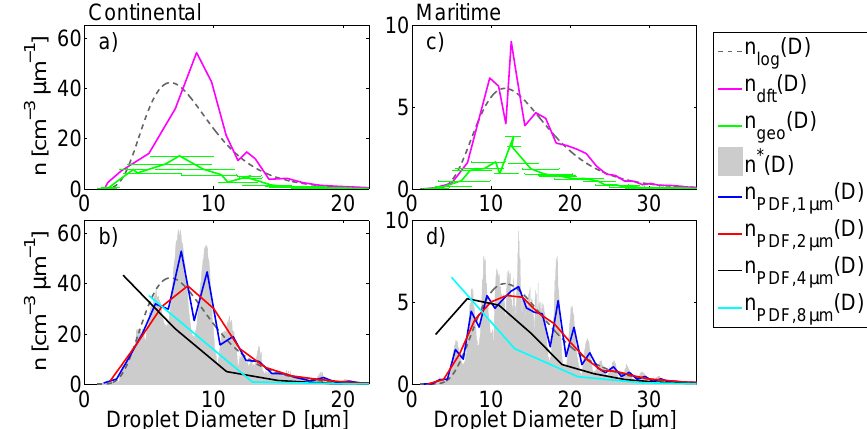
Fig. 6. Modeled sampling behavior of the FM-100 as described in Sect. 4.3.1 for an assumed typical continental (left panels) and maritime (right panels) cloud droplet size distribution n log (D) (gray dashed lines). (a) and (c) Size distribution measured with default channels ( n dft (D) , magenta line) and the Mie channels ( n geo (D) , green line) including maximal and minimal errors for each channel (see Sect. 3.1.1). (b) and (d) Effect of the re-sizing on the apparent size distribution: the discrete droplet number distribution n ∗ (D) with a resolution of 0.02µm (gray area) and four different re-binned size distributions n PDF ,a µ m with bin size 1D = a µm ( a =1, 2, 4 and 8, see Sect. 3.1.2 for